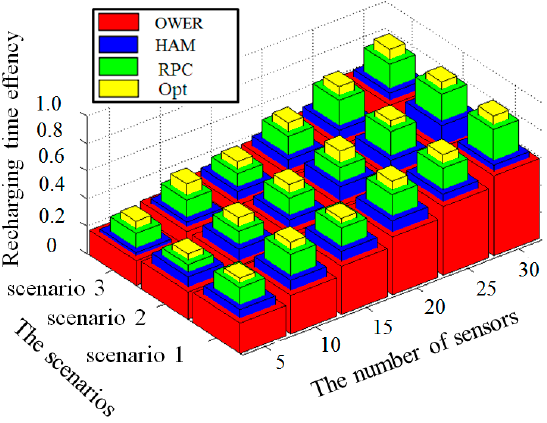
Figure 13. Comparison of the four algorithms in terms of recharging time efficiency in three scenarios.